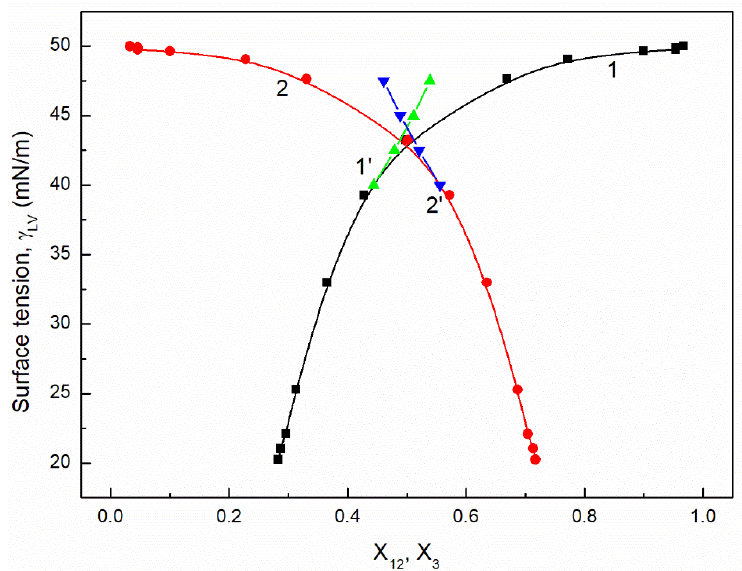
Figure 12. A plot of the surface tension ( γ LV ) of the aqueous solutions of CTAB + TX100 + FC2 mixture at the constant concentration of the binary mixture CTAB + TX100 (C 12 ) and γ LV = 50 mN/m (m2 (50)) vs. the composition of the ternary mixture in the monolayer ( X 12 and X 3 ) determined (curves 1 and 2) and calculated from Equation (5) (curves 1’ and 2’). 𝑋 (cid:2869)(cid:2870) corresponds to the sum of